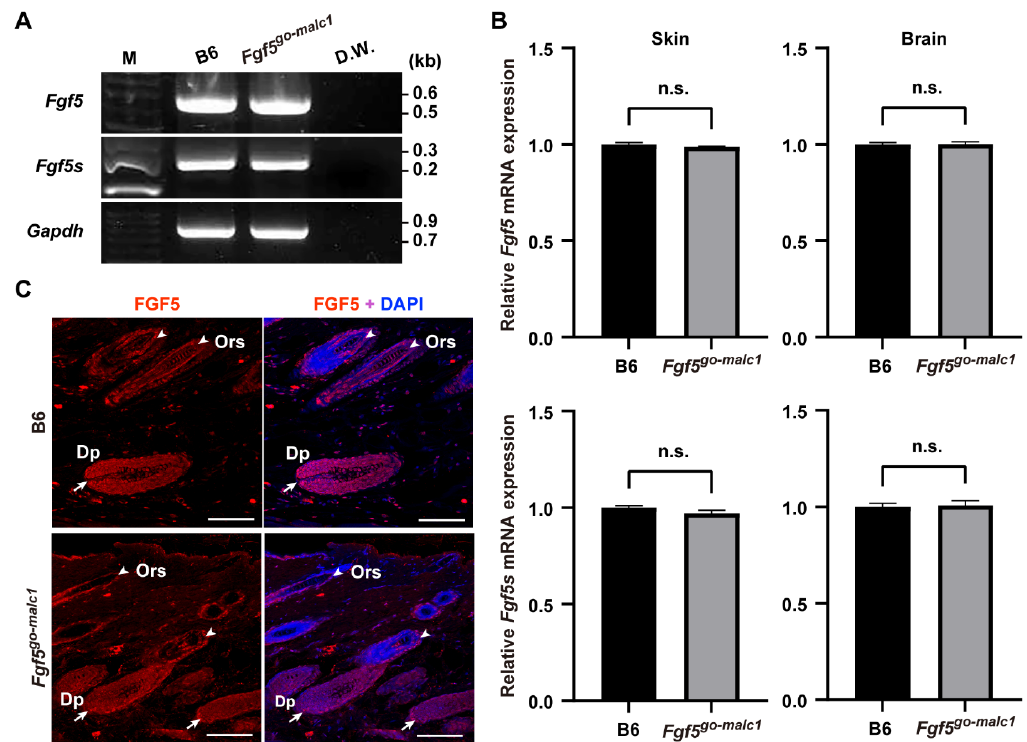
Figure 3. Analysis of FGF5 and FGF5S expression in Fgf5 go-malc1 mice. ( A ) Semi-quantitative RT-PCR analysis of Fgf5 and Fgf5s transcripts in the skin. M: 100-bp DNA ladder. D.W.: distilled water. ( B ) Relative expression of Fgf5 (upper graphs) and Fgf5s (bottom graphs) transcripts in the skin (left graphs) and brain (right graphs) of C57BL/6J (B6) and Fgf5 go-malc1 mice. Black and gray bars indicate values of relative expression levels of Fgf5 and Fgf5s transcripts in B6 and Fgf5 cr mice, respectively ( n = 3; geometric means ± standard deviation). n.s.: no significant differences. ( C ) Immunohistochemical localization of FGF5 protein (red) in the skin of B6 (upper panels) and Fgf5 go- malc1 mice (bottom panels). Nuclei were counterstained with DAPI (blue). Arrows and arrowheads indicate the dermal papilla (Dp) and outer root sheath (Ors) in the hair follicles, respectively. Scale bar = 100 µm. 2.3. Prolonged Anagen Phase in Fgf5 go-malc1 Mice Fgf5- null mice exhibit a long-haired phenotype due to a prolonged anagen phase in the hair cycle [29]. A similar mechanism has been reported in the Fgf5 malc hamsters [16]. To examine whether the long-haired phenotype in Fgf5 go-malc1 mice is also associated with a prolonged anagen phase, histological sections of the skin were prepared from WT and Fgf5 go-malc1 mice at P13 and P21. At P13, when the first hair cycle occurred after birth [30], the presence of Dp and Ors was discernible in both WT and Fgf5 go-malc1 mice, irrespective of sex, indicating that the hair cycle was in the anagen phase (Figure 4A). At P21, the skin from the WT mice showed the presence of hair clubs (Hc), which is suggestive of the telogen phase (Figure 4B, white arrows). In contrast, the skin from Fgf5 go- malc1 mice at P21 showed the presence of Dp in the follicles (Figure 4B, black arrows), suggesting that the anagen phase was prolonged in these mice (Figure 2B). Previous studies have shown that apoptosis is frequent in skin cells during catagen and telogen phases [16]. Next, we performed TUNEL staining to evaluate apoptotic cells for a more precise determination of the hair cycle phase. As expected, in the Hc of WT mice, apoptotic cells were frequently observed (Figure 4C, white arrowheads). In contrast, the number of